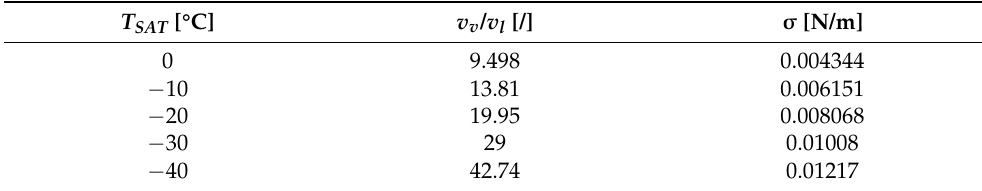
Table 6. Variation in properties (specific volume ratio and surface tension) with respect to different saturation